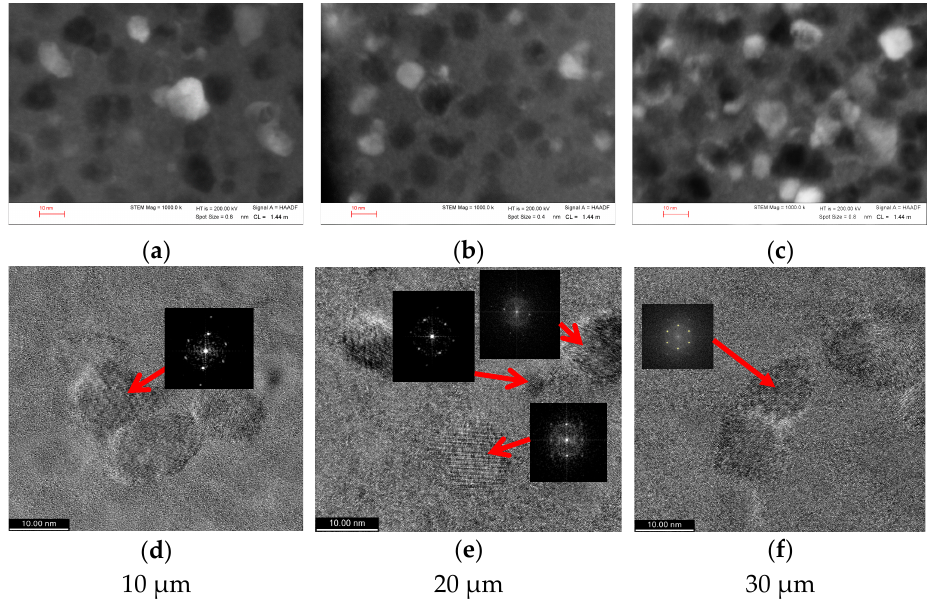
Figure 3. ( a – c ) The evolution of the grain sizes and density for cold-drawn Fe 73.5 Si 13.5 B 9 Cu 1 Nb 3 mi- crowires with various diameters, annealed at 500 °C for 1 h. ( d – f ) The UHR-TEM and SAED images of the same samples indicate similar bcc α -Fe(Si) grain sizes (between 10 and 15 nm), randomly oriented. The axial magnetization curves and the variation of the relative magnetic permeabil- ity versus applied magnetic field in the case of the glass-coated, glass-removed, and cold- drawn nanocrystalline microwire samples having an actual metallic wire diameter of 30 µm, are shown in Figure 4. All measurements were performed on 10 cm long samples using a driving field frequency of 50 Hz. The measurements were performed on samples annealed for 1 h at 500 °C, which exhibit the highest magnetic permeability and significant stress dependence, in agreement with previous reports [15,19].